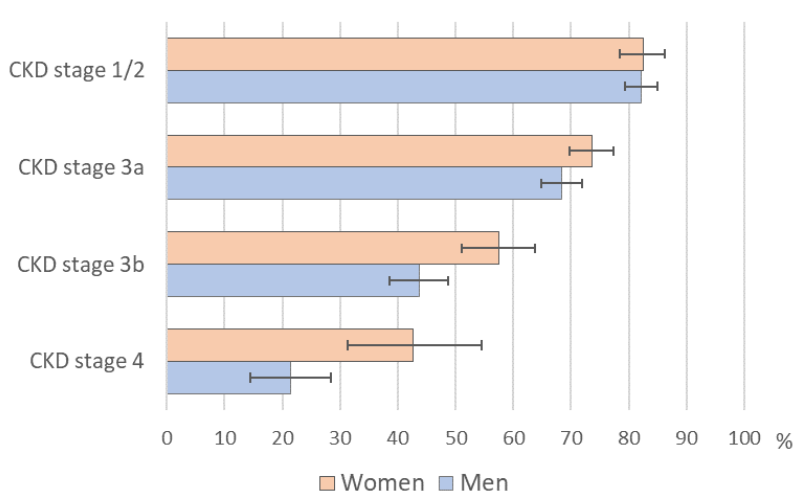
Figure 5. Sex difference in unawareness for chronic kidney disease (CKD) by CKD stage; prevalence of CKD unawareness with 95% confidence intervals. German CKD related cohorts (CORE database), N = 3305, 2010.